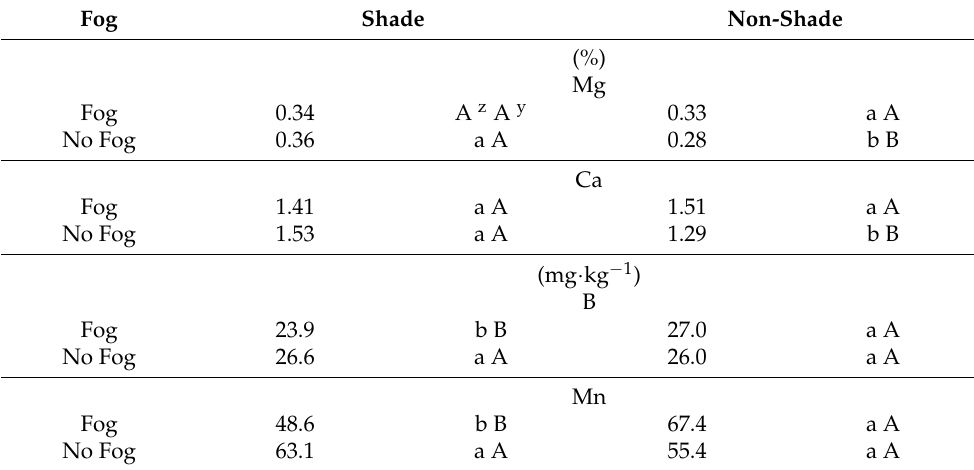
Table 3. Interaction between fogging and shading for foliar magnesium (Mg), calcium (Ca), boron (B), and manganese (Mn) concentrations on a dry weight basis in high tunnel-grown lettuce ‘Salanova Red